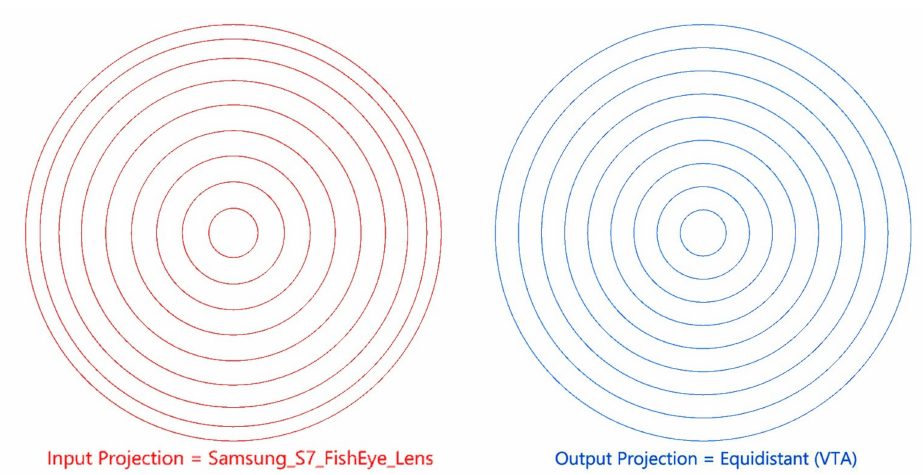
Figure 11. The input projection rings for the optical system of the fisheye lens Samsung Galaxy S7 colored in red and the equidistance output projection in blue.